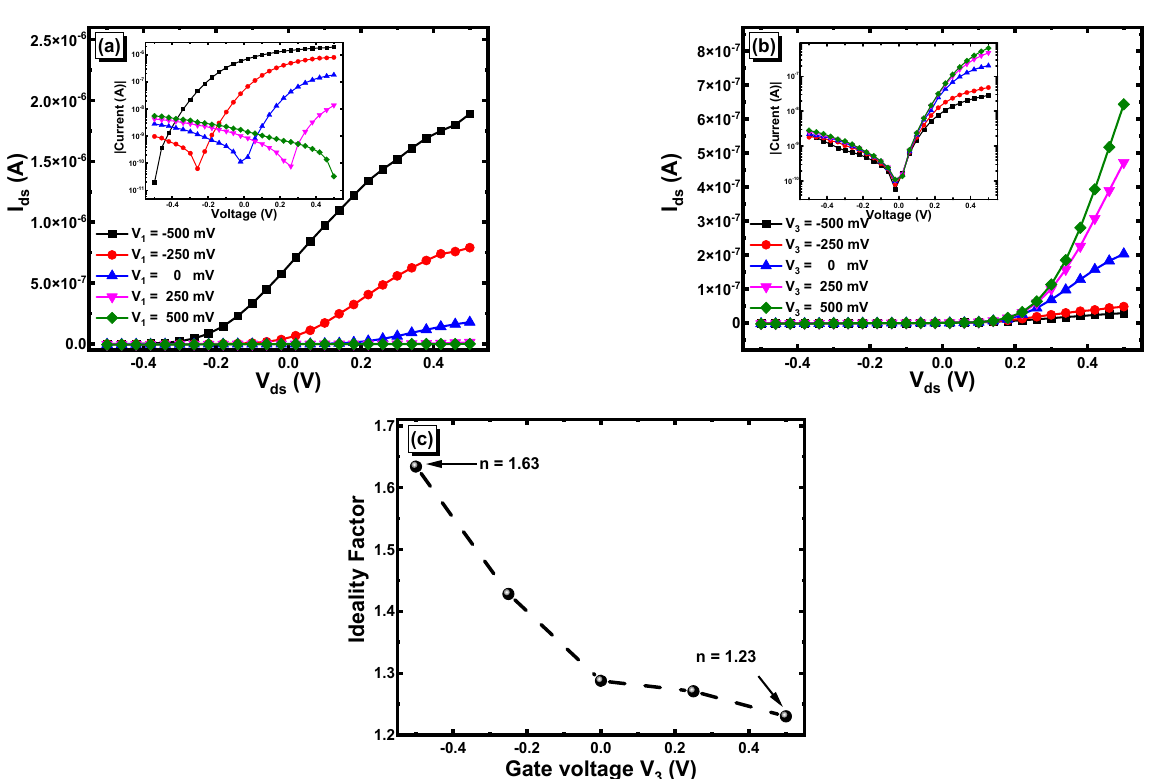
Figure 4. Output characteristics in dark conditions of ( a ) n-MoSe 2 /p-BP when MTL Gr was used as the gate and ( b ) Gr/n-MoSe 2 when MTL p-BP was used as the gate; ( c ) ideality factor of Au/Gr/n- MoSe 2 /Au heterojunction vs. gate voltage.